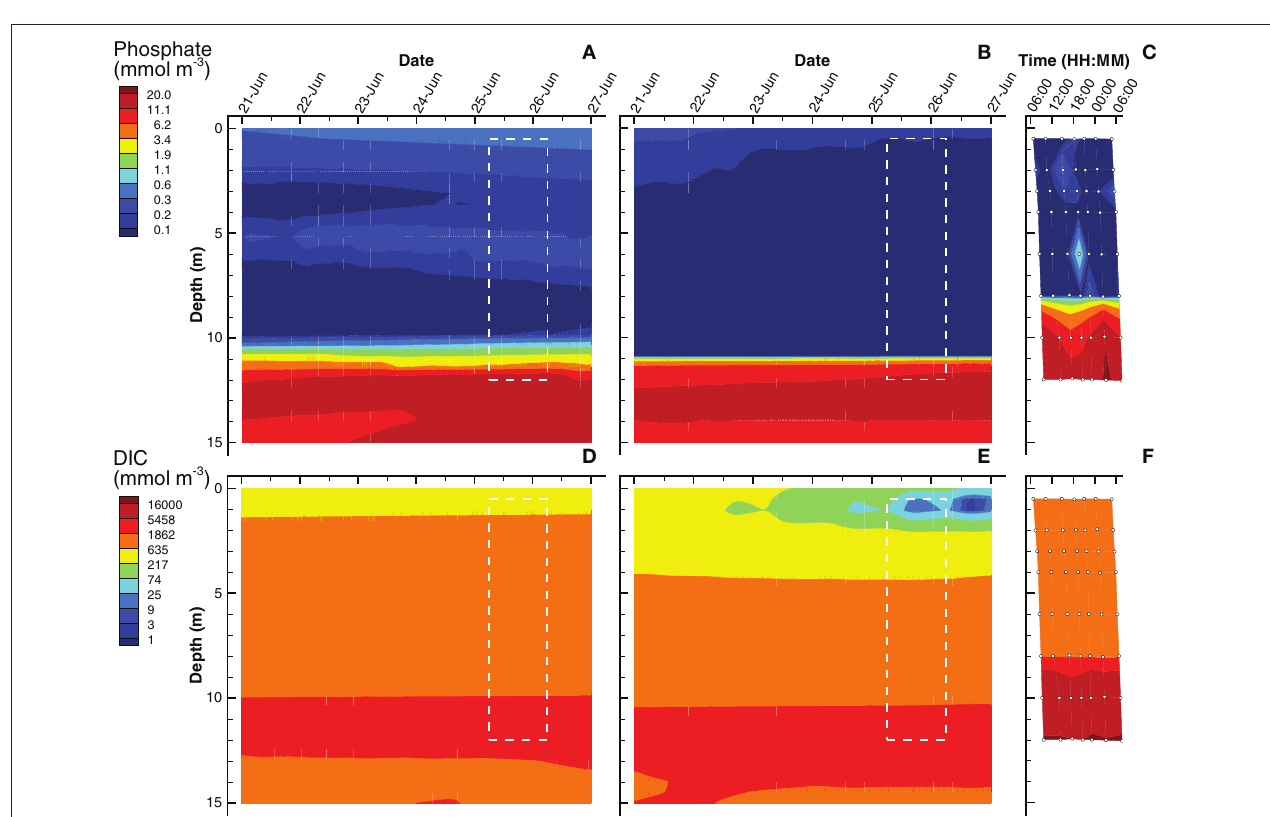
Better (i.e., lower) scores are highlighted in bold italic font